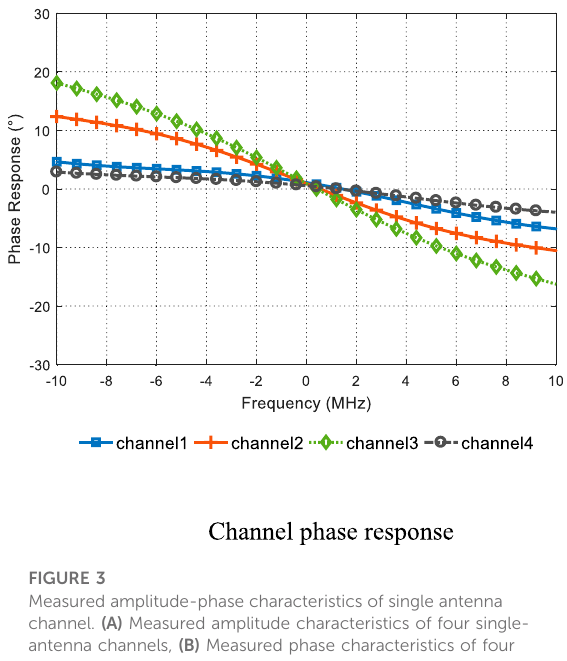
FIGURE 3 Measured amplitude-phase characteristics of single antenna channel. (A) Measured amplitude characteristics of four single- antenna channels, (B) Measured phase characteristics of four single-antenna channels.